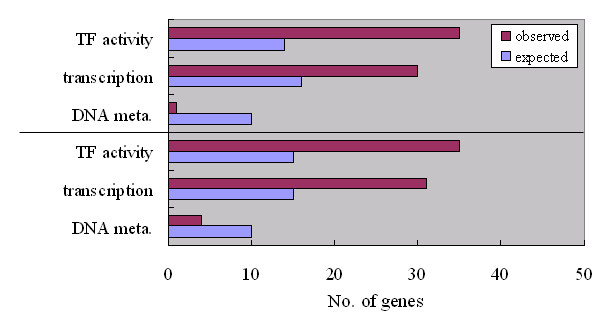
Annotation enrichment and depletion of CNMS associated genes. In the top half of the figure, the maroon bars ("observed") give the numbers of orthologous CNMS genes that are annotated in the Arabidopsis GO database with molecular function "transcription factor activity" or biological process "transcription regulation" and "DNA metabolism". The blue bars ("expected") give the number of genes that one would expect to obtain if the same number of genes were chosen at random among all genes annotated in the relevant database. The bottom half of the figure gives similar information for paralogous CNMS genes in Arabidopsis.